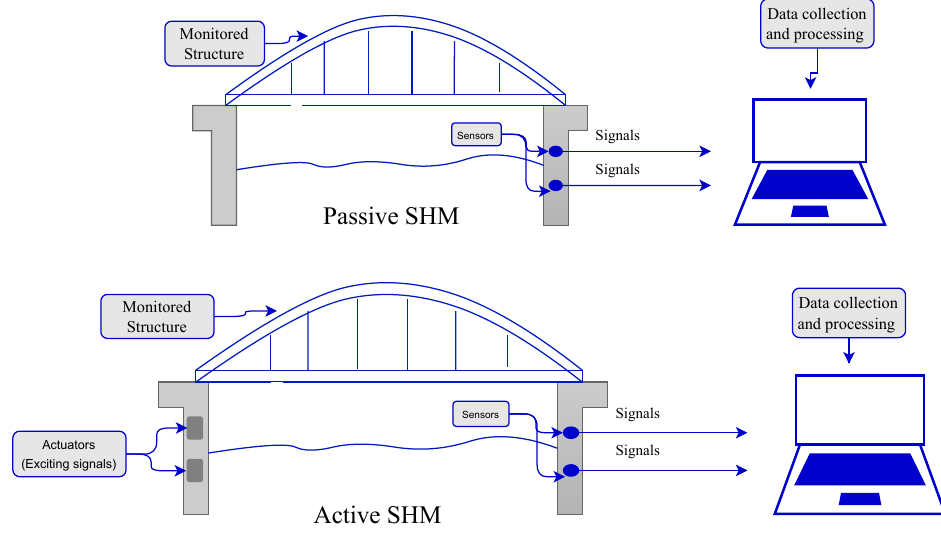
Figure 1. Passive and active SHM